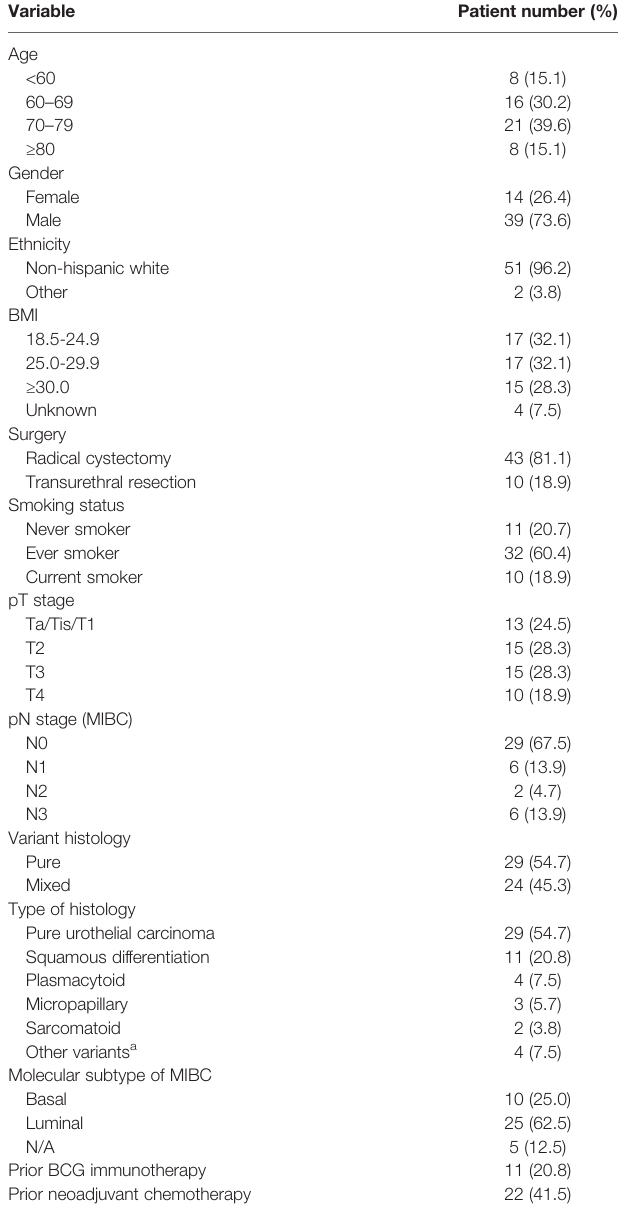
TABLE 1 | Characteristics of 53 bladder cancer patients included in the analysis.